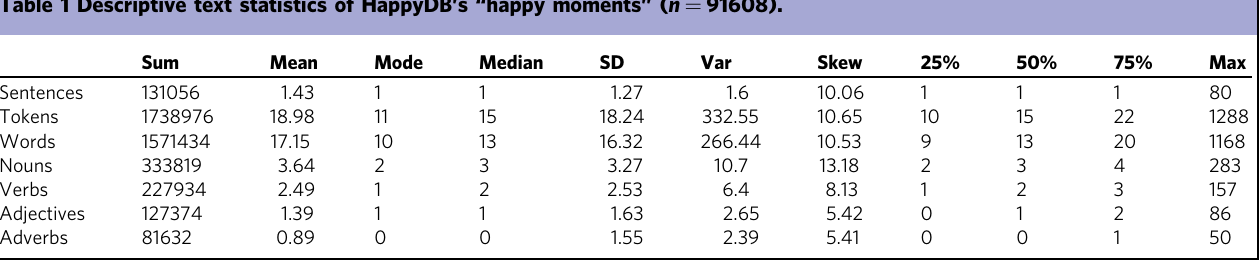
Fig. 1 Distribution of happy moments by category. The size of the categories varies greatly, with ACHIEVEMENT and AFFECTION being the most salient ones. Table 1 Descriptive text statistics of HappyDB ’ s “ happy moments ” ( n =